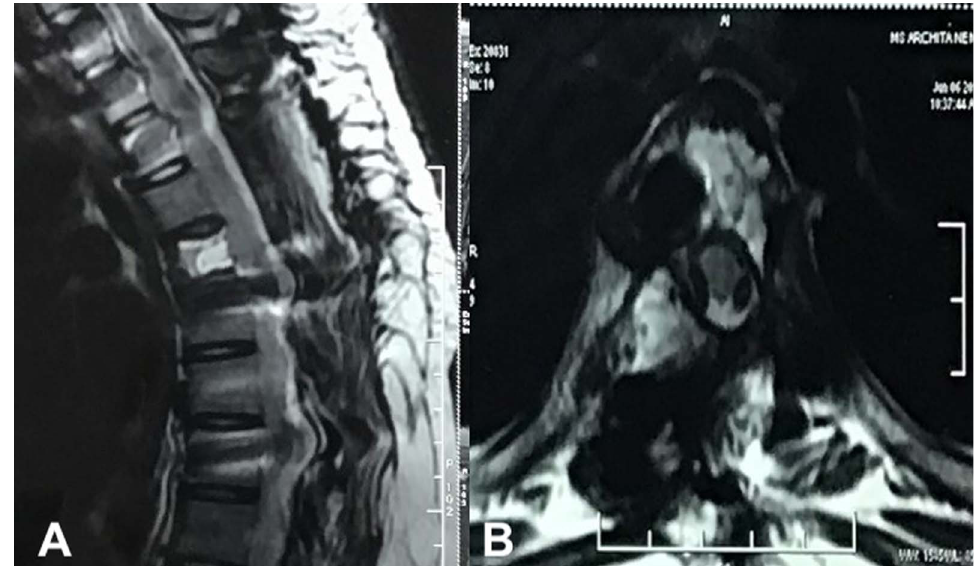
Figure 6. A 6-month follow-up MRI post completion of Denosumab therapy. (A) shows a sagittal T2WI MRI image with resolution of previous dorsal compressive mass and (B) axial image of the decompressed spinal cord.